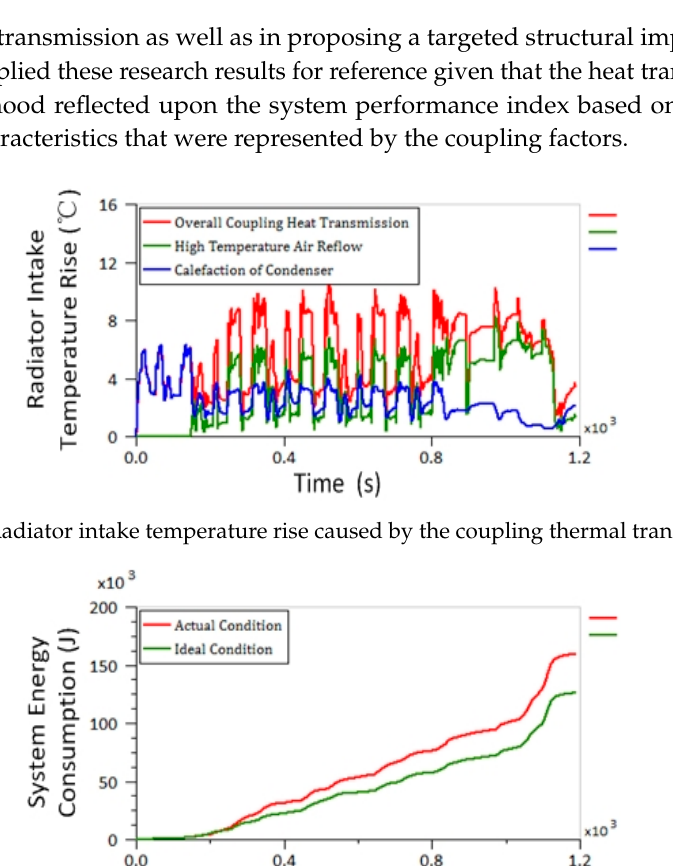
Figure 25. Effects of the coupling thermal transmission on the system energy consumption. Figure 25. E ff ects of the coupling thermal transmission on the system energy